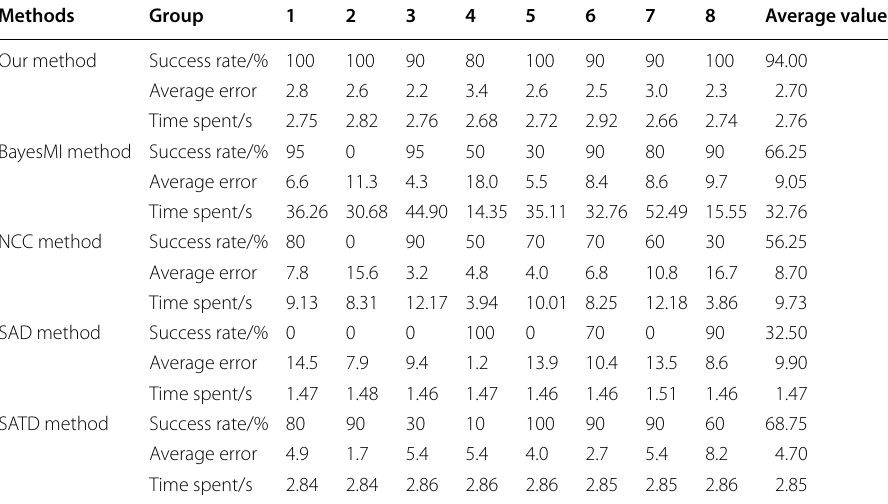
Table 2 Statistics of the experimental results